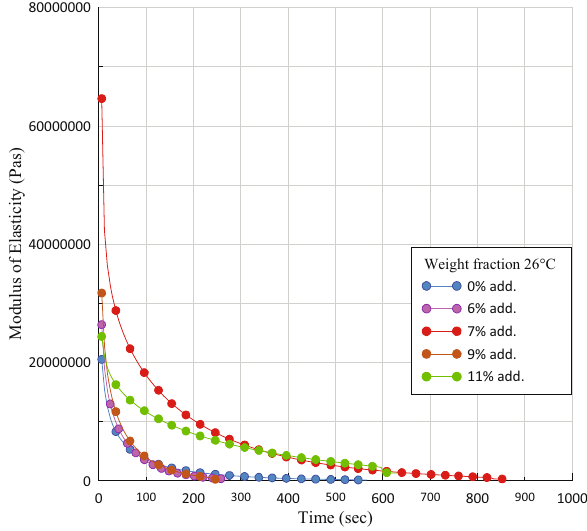
Figure 9: Modulus of elasticity for UP/PS reinforced with fi sh fl akes for di ff erent weight fractions at 26°C.